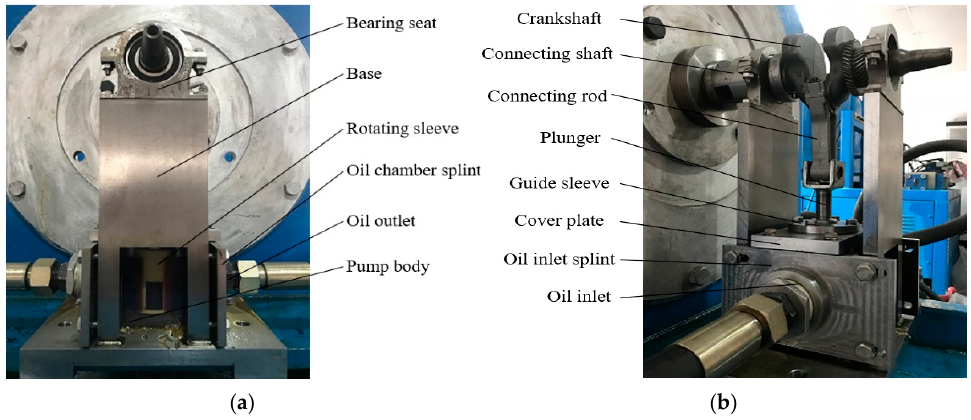
Figure 15. Structure of the RSDF system. ( a ) Front view; ( b ) Left view.